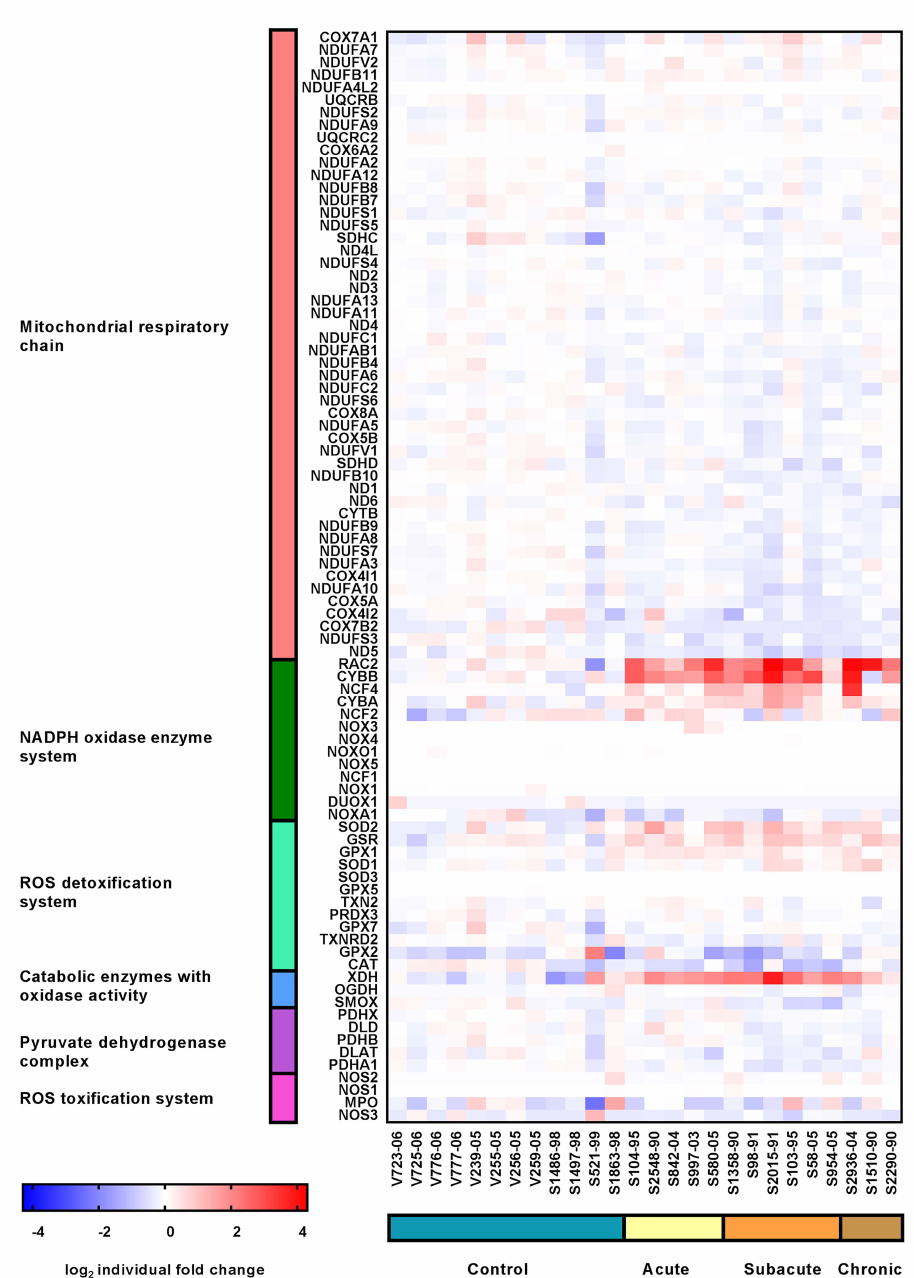
Figure 9. Expression profile of manually selected marker genes (rows) functionally related to mitochondrial respiratory chain (red), NADPH oxidase enzyme system (green), ROS detoxification system (mint), catabolic enzymes with oxidase activity (blue), pyruvate dehydrogenase complex (purple) and ROS toxification system (pink) in the cerebella (columns) of controls (blue), dogs a ff ected by acute CDV-DL (sand), subacute CDV-DL with demyelination but without inflammation (ochre), and dogs a ff ected by chronic CDV-DL with demyelination and with inflammation (brown). Note that the most prominent changes in gene expression are upregulations of genes of the NADPH oxidase enzyme system a ff ecting all subgroups of CDV-DL. The heatmap displays the log2-transformed individual fold changes relative to the mean expression of the controls indicated by a color scale ranging from − 4 (16-fold downregulation) in blue to 4 (16-fold upregulation) in